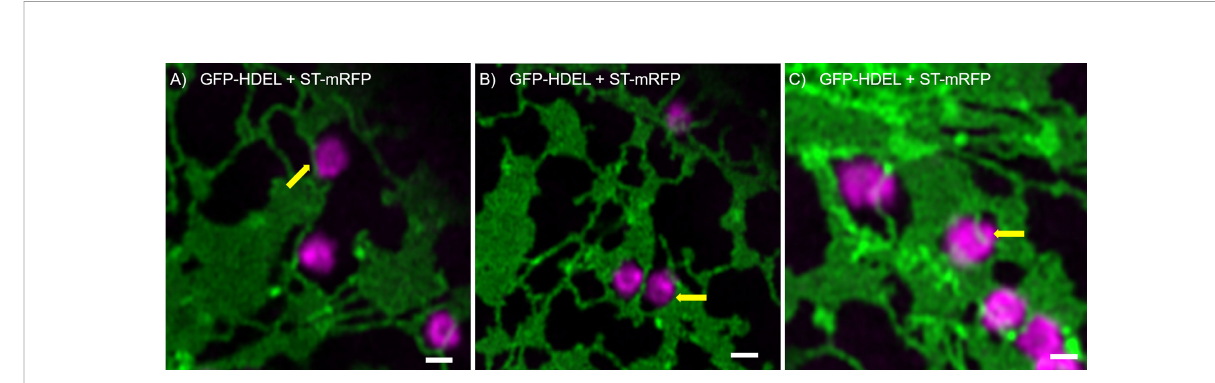
FIGURE 1 ER and Golgi are in close association as demonstrated by high-resolution microscopy. The ER marker GFP-HDEL (in green) and the Golgi body marker ST-mRFP (in magenta) are transiently expressed in tobacco leaf epidermal cells. Golgi bodies are associated with ER tubules (A) , yellow arrow) and cisternal edges ( B , yellow arrow) and can sit in small lacunae within ER cisternae ( C , white arrow). Size bars = 1